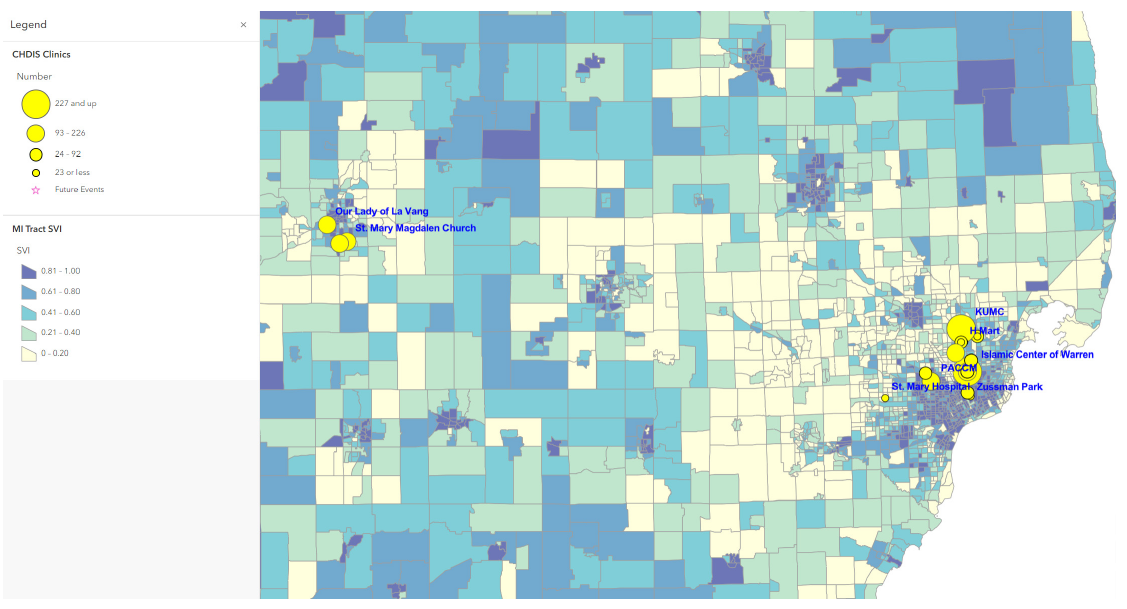
Figure 6. EMU mobile clinics vs. CDC/ATSDR Social Vulnerability Index in Michigan Census Tracts.